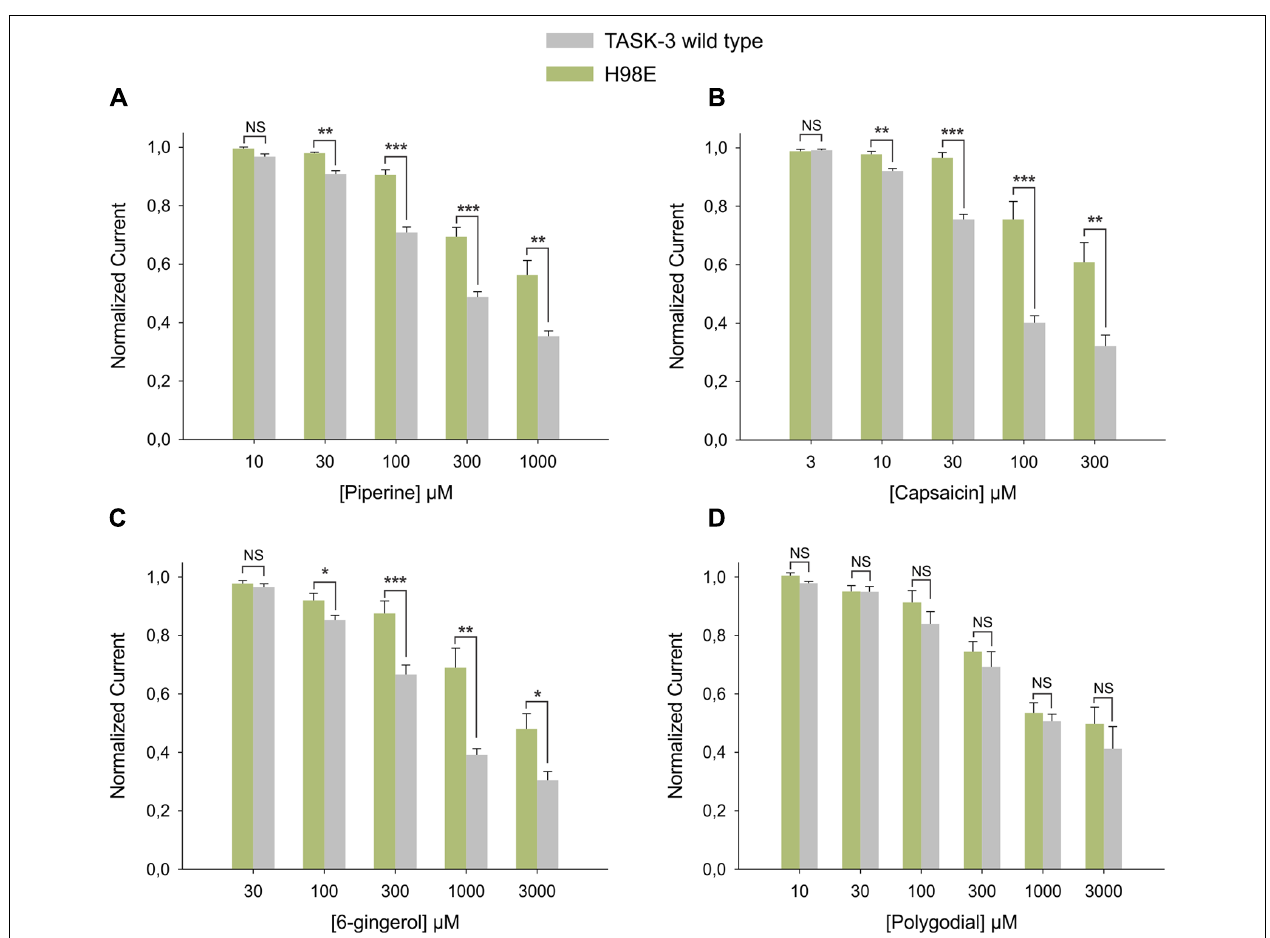
FIGURE 7 | Dose response relationships for the inhibition induced by pungent substances onTASK-3WT (gray bars) vs. H98E (green bars) for (A) piperine, N of 5–12 oocytes; (B) capsaicin, N of 5–10 oocytes; (C) 6-gingerol, N of 3–19 oocytes and (D) polygodial N of 3–9 oocytes. * P < 0.05, ** P < 0.01, *** P <